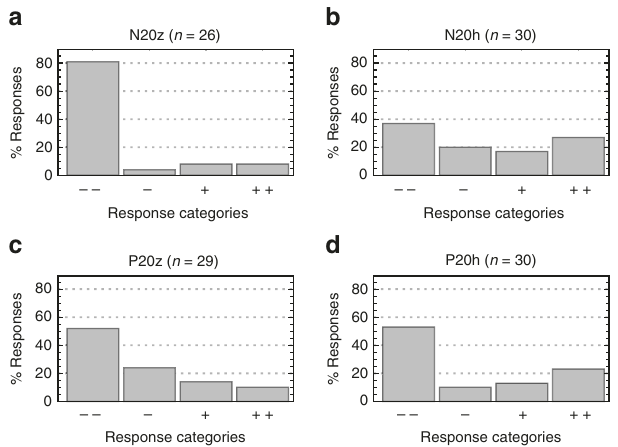
Fig. 4 Distribution of normative attitudes towards contributing